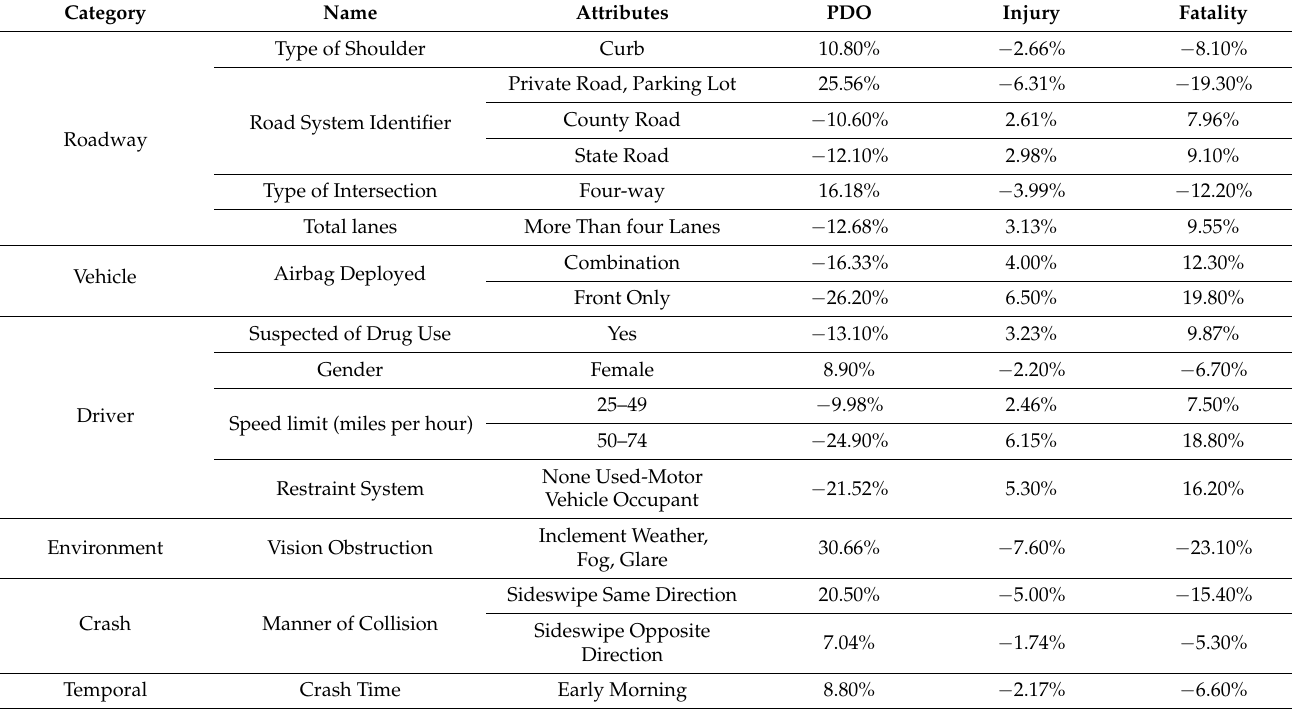
Table 4. Average Pseudo